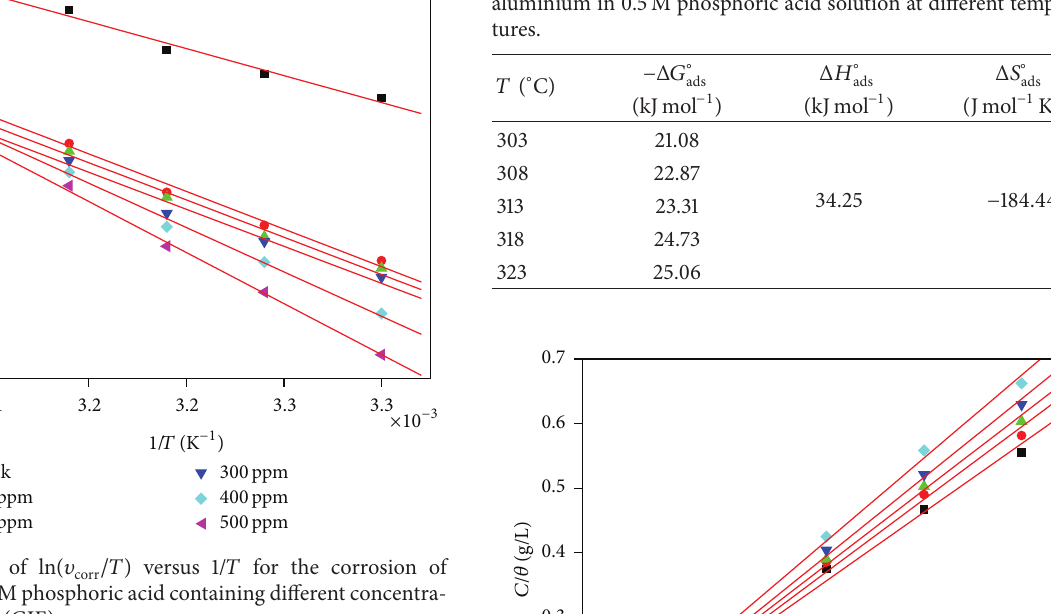
Table 4: Thermodynamic parameters for the adsorption of GIE on